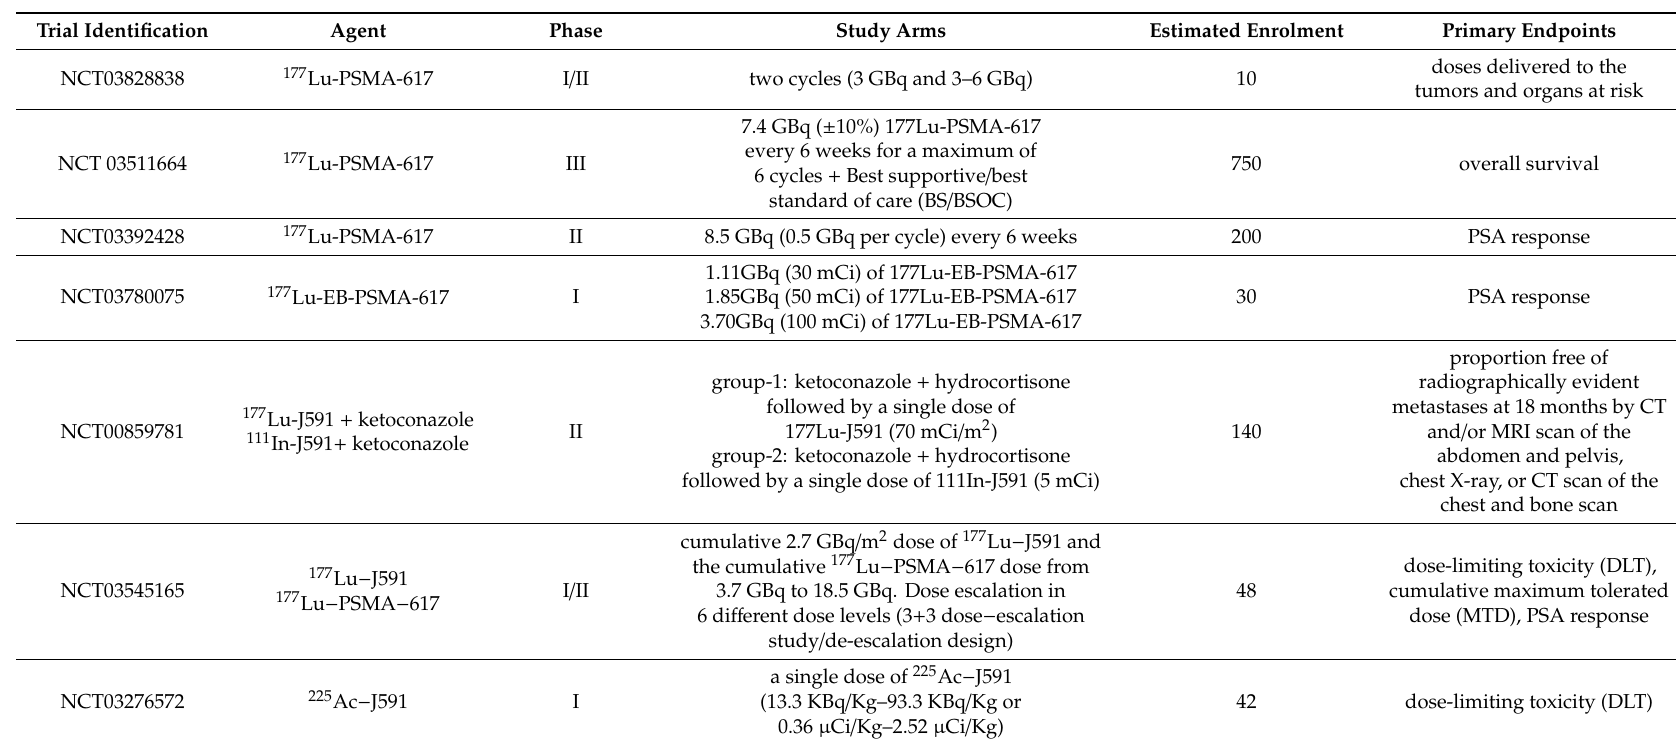
Table 4. Ongoing clinical trials of radiopharmaceuticals for targeted prostate cancer